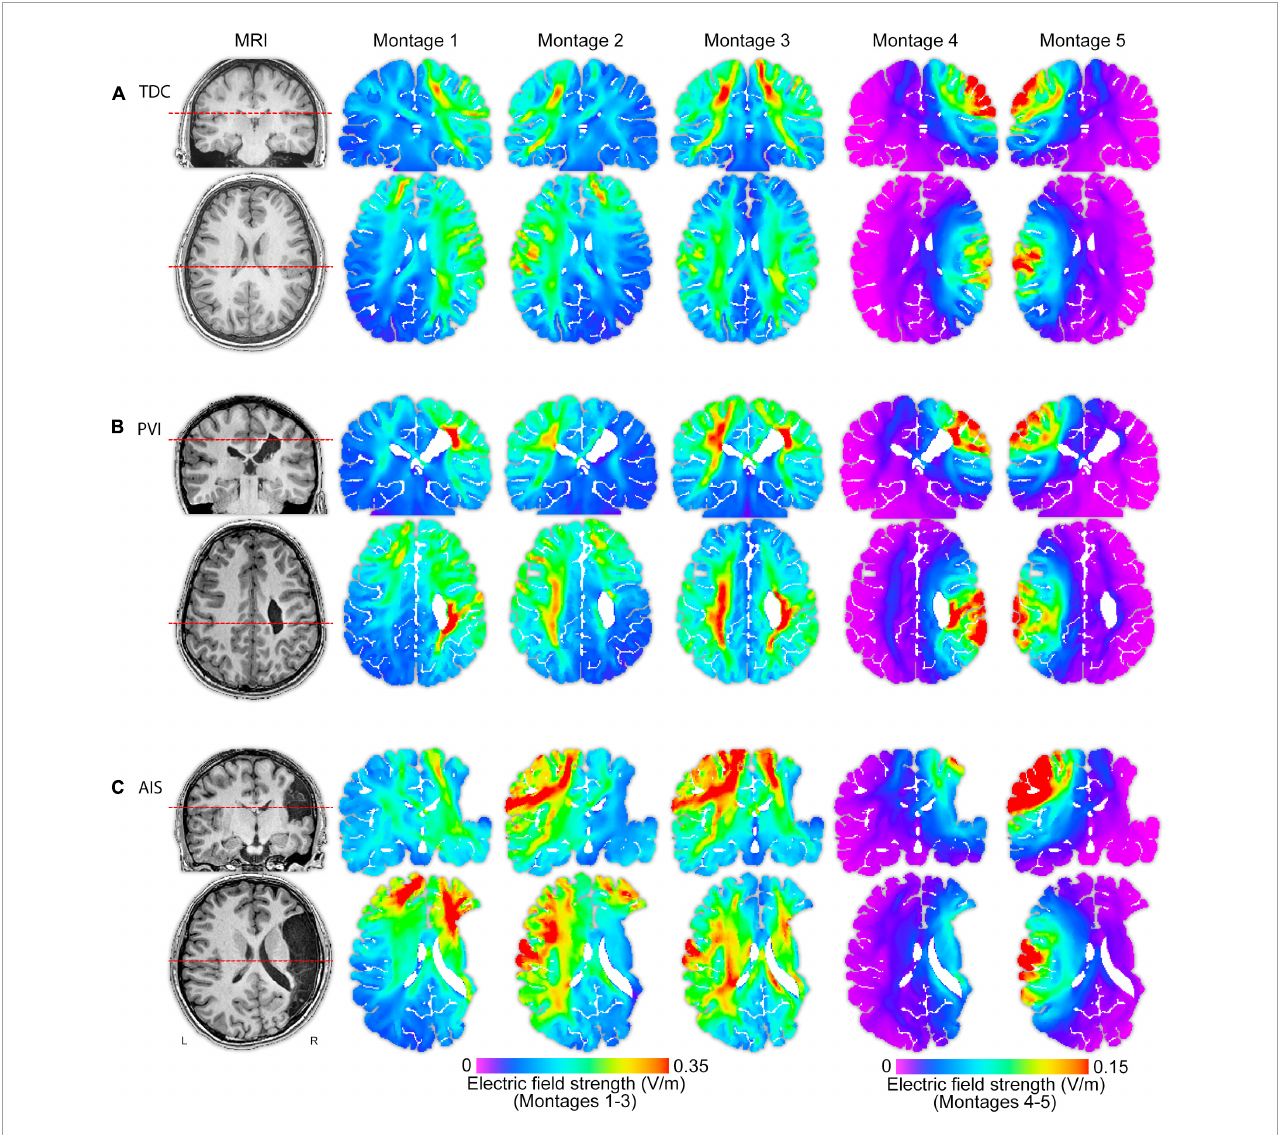
FIGURE3 T1-weighted anatomical images and electric field (EF) strength (V/m) parametric maps for five montages for three individual participants (of similar ages 13.5, 13.1, and 15.0 years) from each of the (A) TDC, (B) PVI, and (C) AIS groups. These images illustrate that EF peak strengths, peak locations and field distributions vary idiosyncratically across patients and montages. The same MRI slices (denoted by dotted line) for each participant are shown in each row, though slice position varies between participants based on individual anatomy. Note that the EF strength scales are the same within montages 1–3 though different from montages 4–5. TDC, typically developing control; PVI, periventricular infarction; AIS, arterial ischemic stroke.